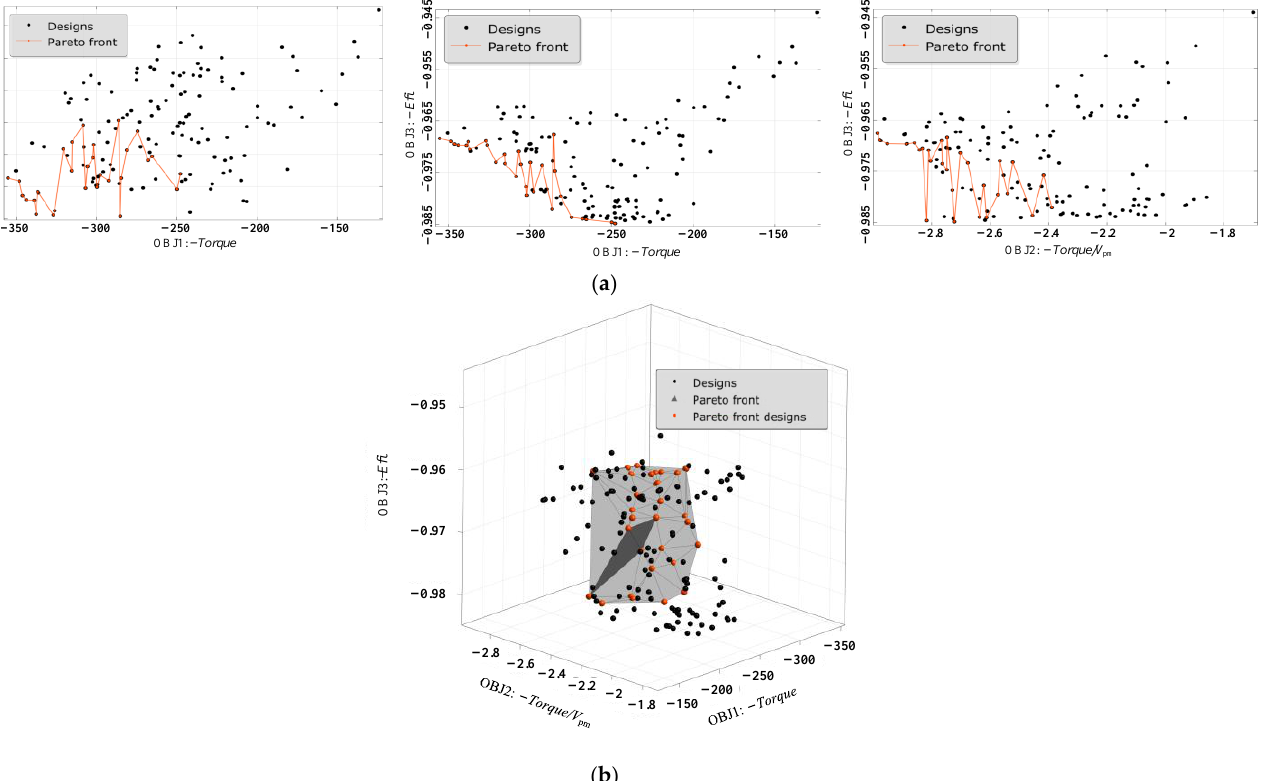
Figure 8. 2D and 3D Pareto solutions of global optimization. ( a ) 2D Pareto solutions. ( b ) 3D Pareto solutions.